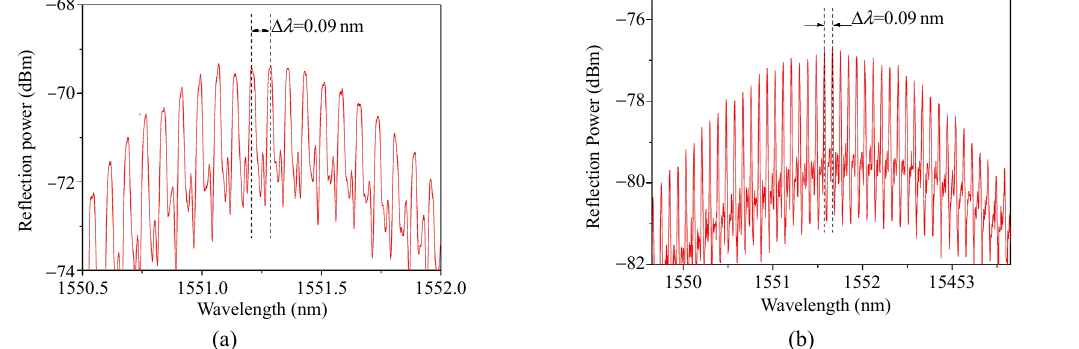
Fig. 3 Reflection spectra of SFGs prepared by the point-by-point scanning method with different parameters: (a) a = 0.6 mm, p = 10 mm, and L = 100 mm; (b) a = 0.4 mm, p = 8 mm, and L = 80 mm.